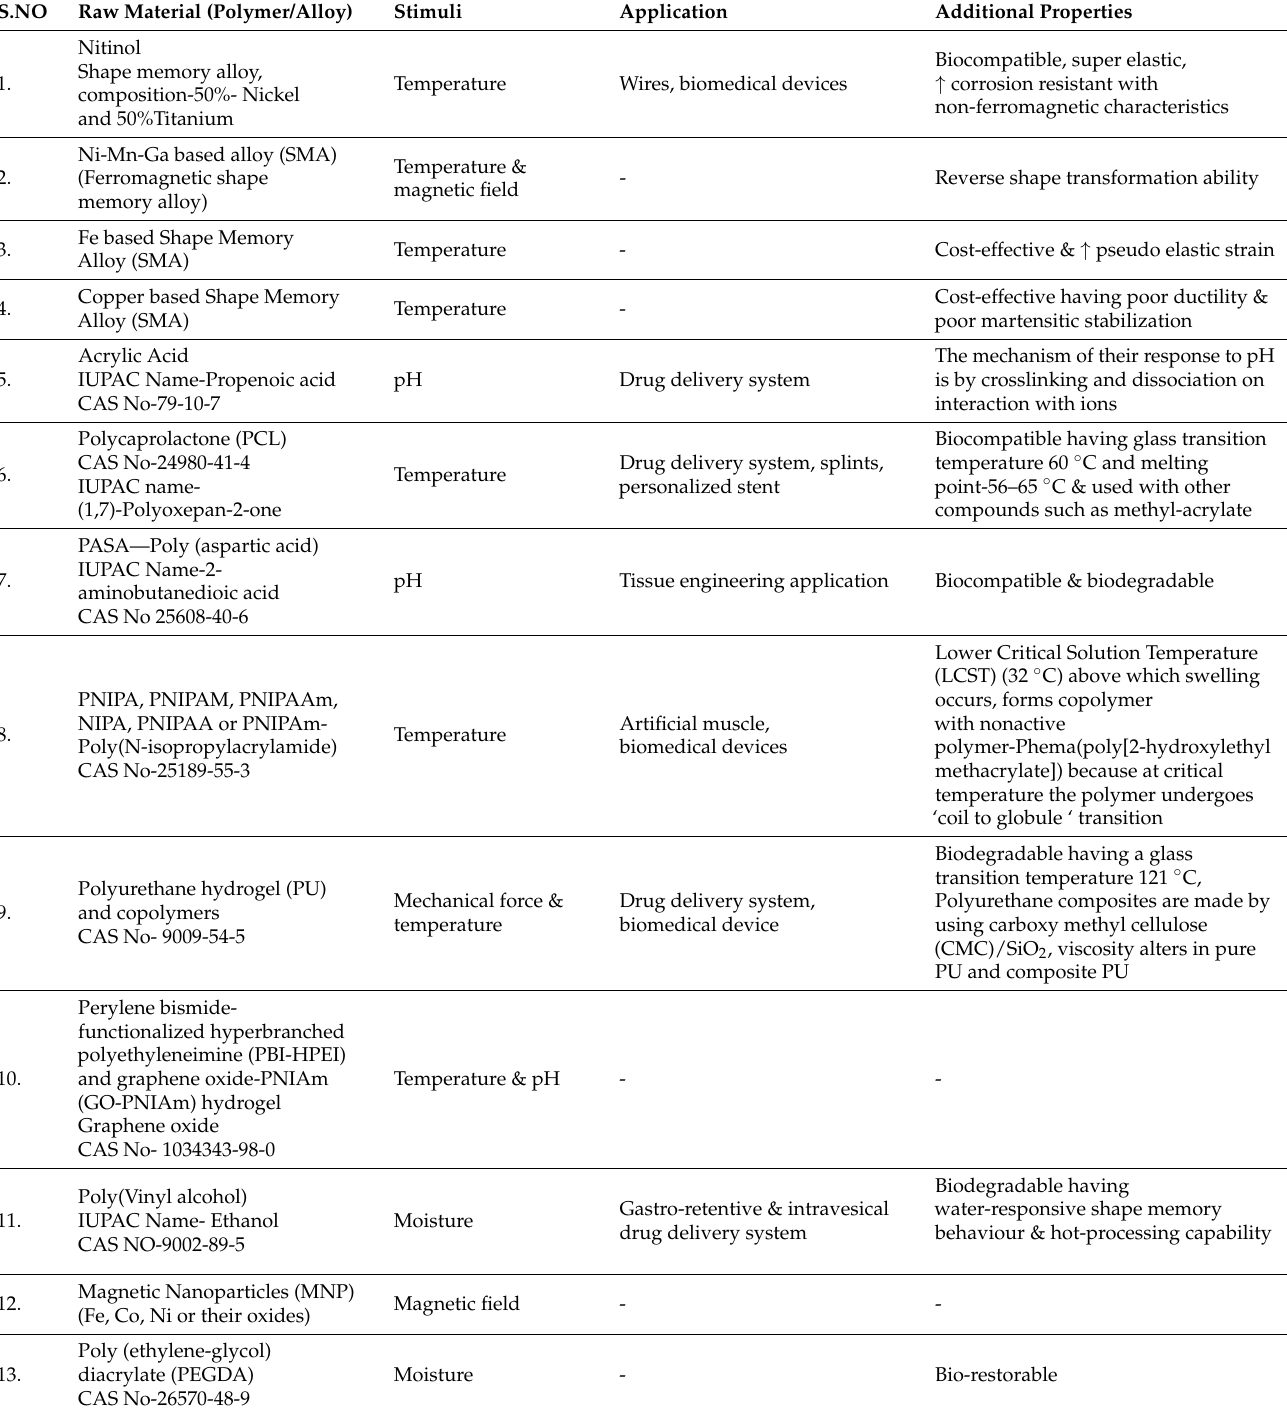
Table 1. Raw materials used in 4D Printing with their application and properties. The raw materials include SMPs, SMAs and Magnetic Nano Particles having specific stimuli like temperature, pH, etc., with their characteristic properties. The applications of some are also mentioned, such as in drug delivery systems, biomedical devices and smart muscle. SMPs may be used as copolymers. SMAs generally respond to